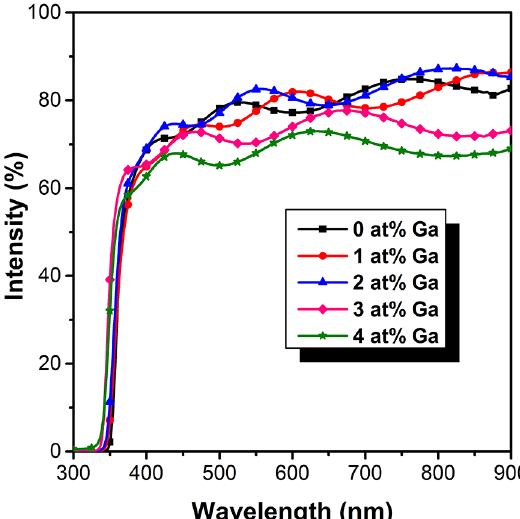
Ca O thin films. 0.85 0.15